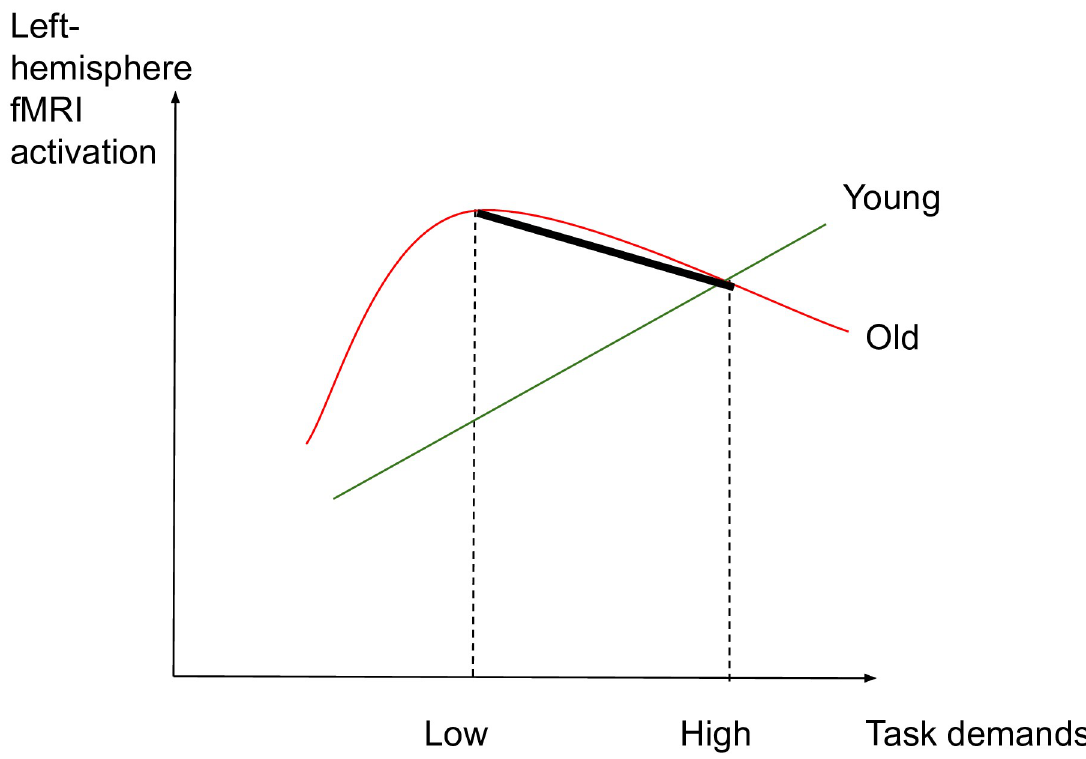
Fig 3. Left-hemisphere activation and task demands in younger and older